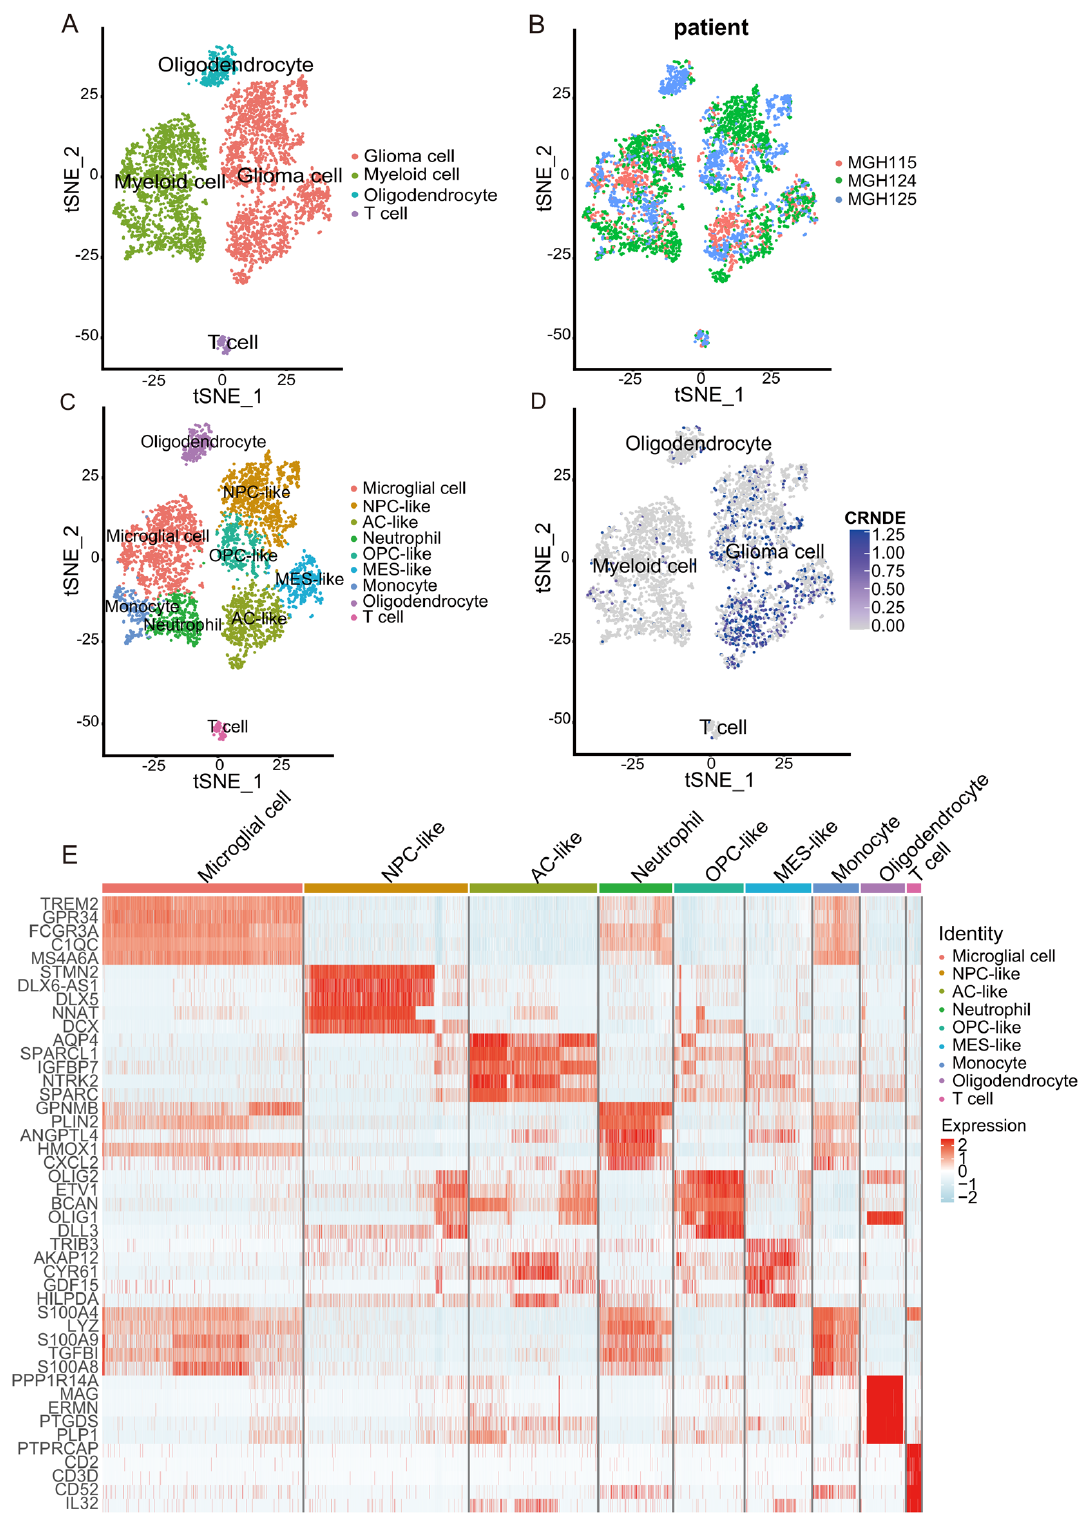
Figure 7. Overview of the scRNA-seq data from 3 glioma samples. ( A – D ) tSNE plot of the 5311 cells with each cell color-coded by ( A ) major cell type, ( B ) patient ID, ( C ) minor cell type, and ( D ) the expression level of CRNDE. ( E ) Heatmap of the top 5 marker genes for each cell type.